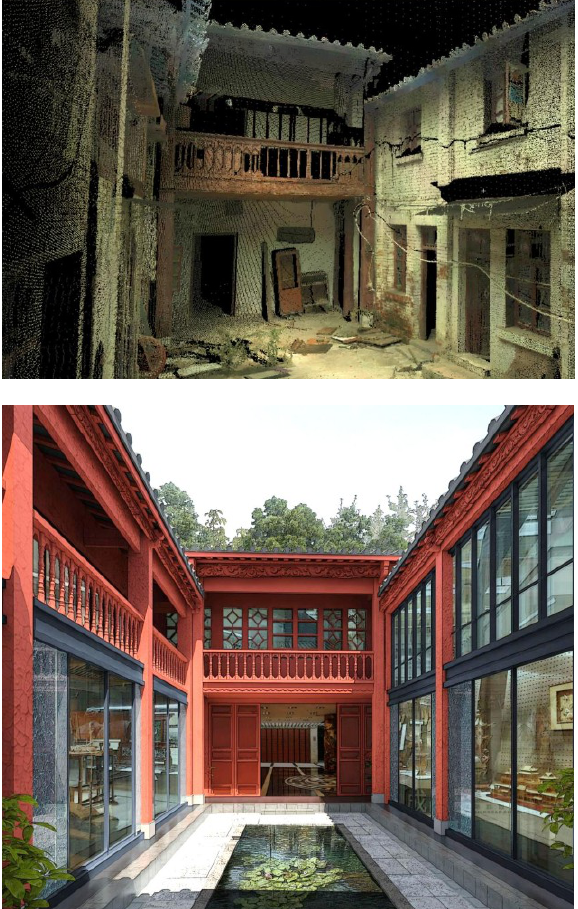
Figure 6. Historic Building and Renovation